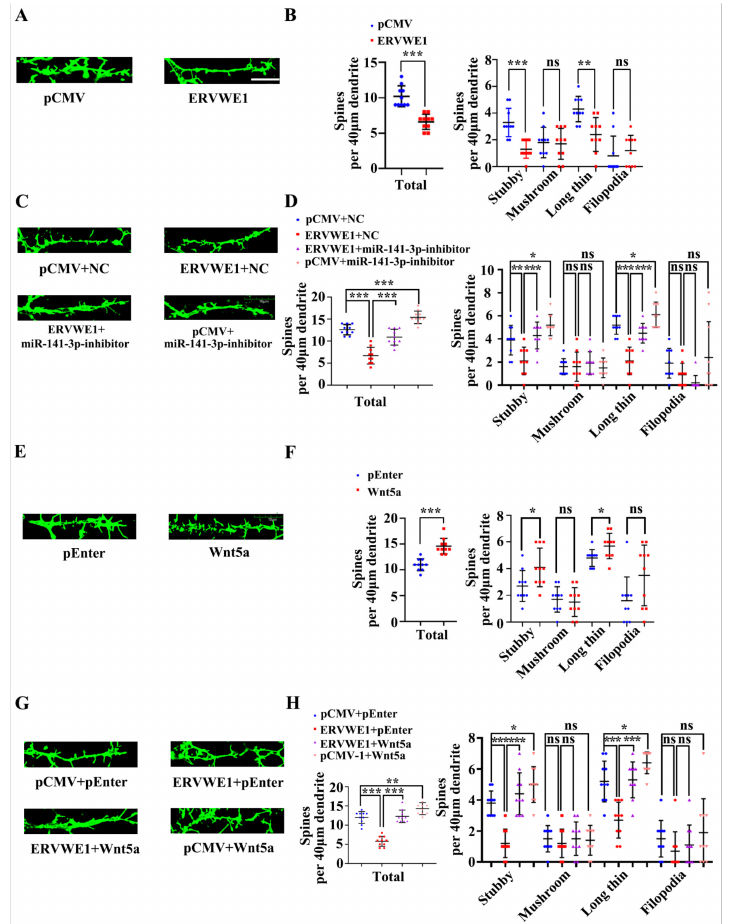
Figure 7. ERVWE1 altered dendritic spine morphology through miR-141-3p/Wnt5a in rat hip- pocampal neurons. ( A ) Fluorescence micrographs revealed that a decreased number of spines in rat hippocampal neurons with ERVWE1. ( B ) The statistics for the total and classified spine numbers per 40 µ m dendrite for A, quantification of spine morphology reveals a decreased number of stubby and long-thin spines. ( C ) The number of spines might be recovered by miR-141-3p by fluorescence images of neurons labeled with phalloidin. ( D ) The statistics for the total and classified number of spines per 40 µ m dendrite were calculated for C. ( E ) Fluorescence micrographs revealed that an increased number of spines in rat hippocampal neurons with Wnt5a. ( F ) The statistics for the total and classified number of spines per 40 µ m dendrite were calculated for E, quantification of spine morphology reveals an increased number of stubby and long-thin spines. ( G ) A phalloidin-labeled neuron showed that Wnt5a might restore spine number. ( H ) The statistics for the total and classified number of spines per 40 µ m dendrite were calculated for G. *** p < 0.001, ** p < 0.01, * p < 0.05, ns: p >